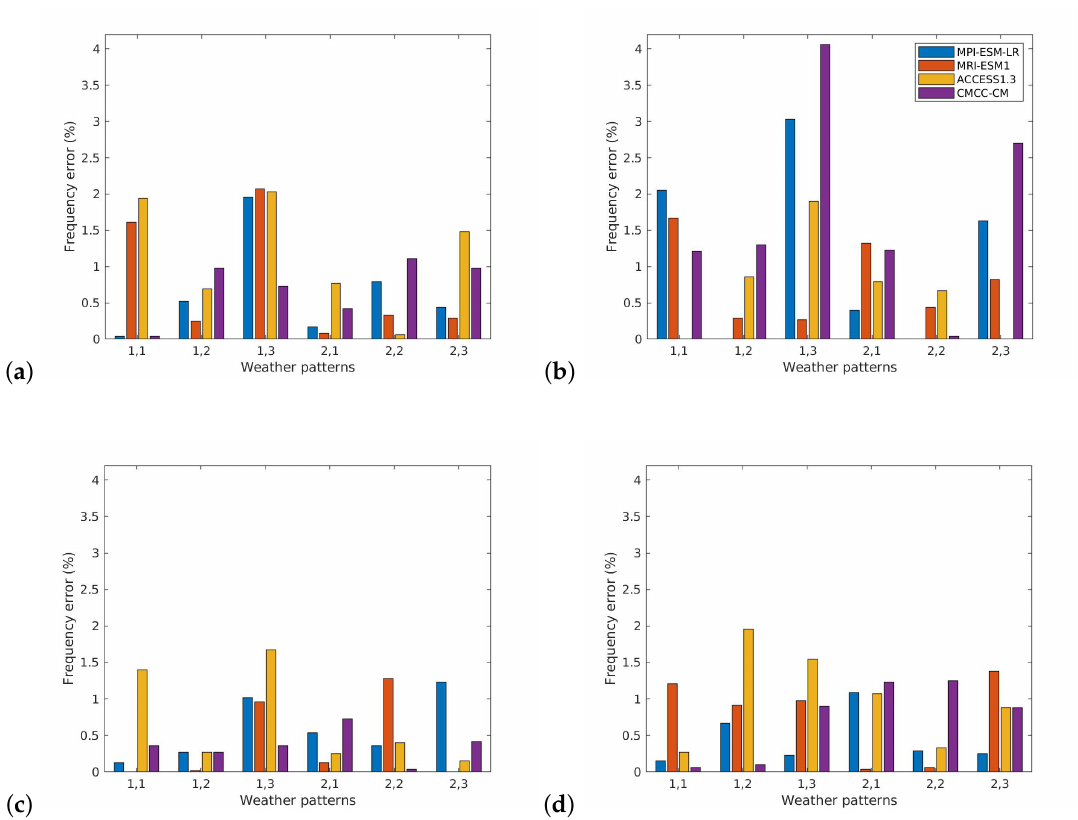
Figure 7. Absolute error in the frequency of occurrence (in %) of WPs in models with respect to ERA-Interim: ( a ) mslp, ( b ) q700, ( c ) u700, and ( d ) v700.